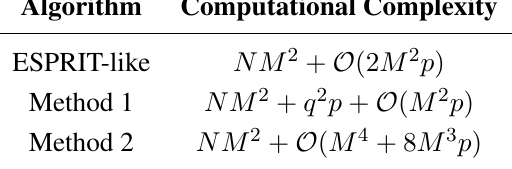
Table 1. Computational complexity of the ESPRIT-like and the proposed two techniques.